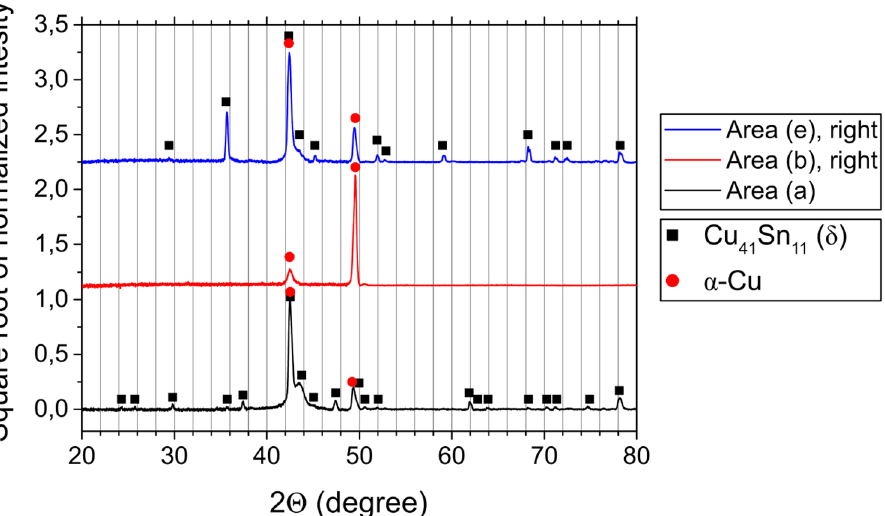
Figure 2. Diffraction patterns of Cu 86 Ga 5 Sn 9 measured at three different positions along the sample rod, with the designation of the measured areas referring to Fig. 1. For a clearer view, the intensity range of areas ( b ) and ( e ) was